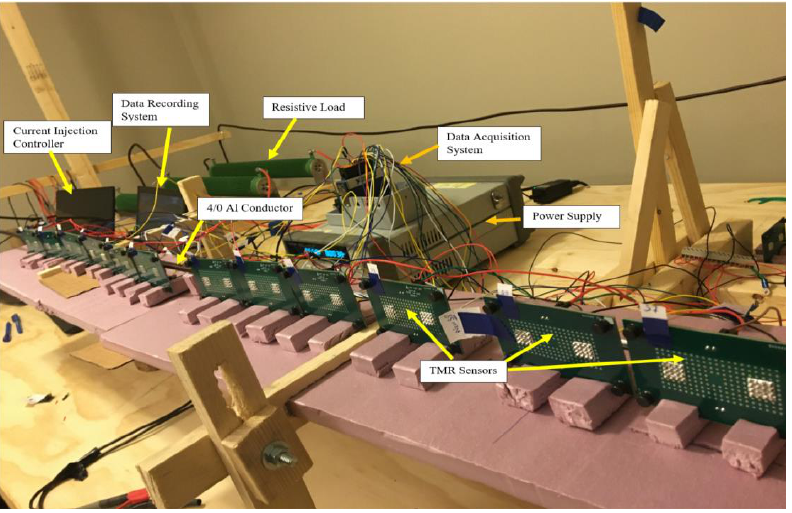
Figure 2. Experimental setup with twelve sensors.